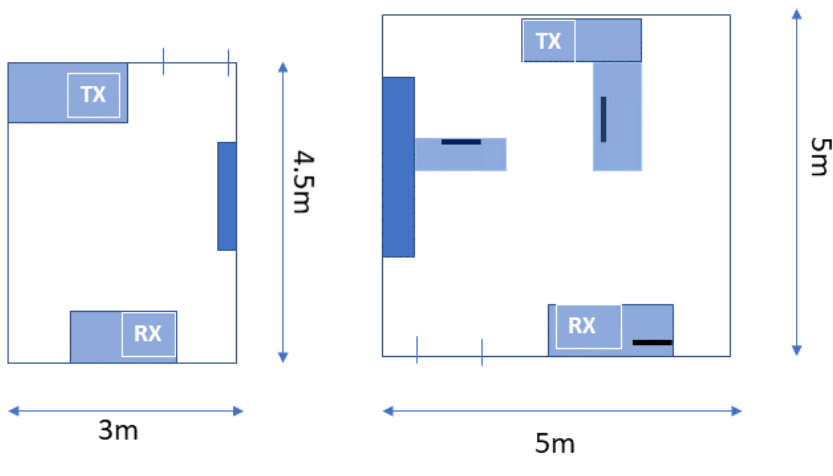
Figure 2. Layout of Room A and Room